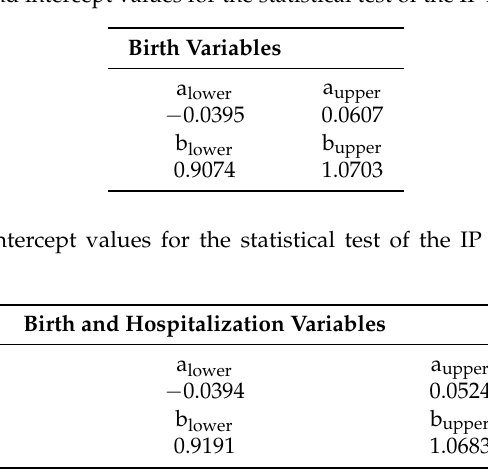
Table A3. Slope and intercept values for the statistical test of the IP ANN model at birth.